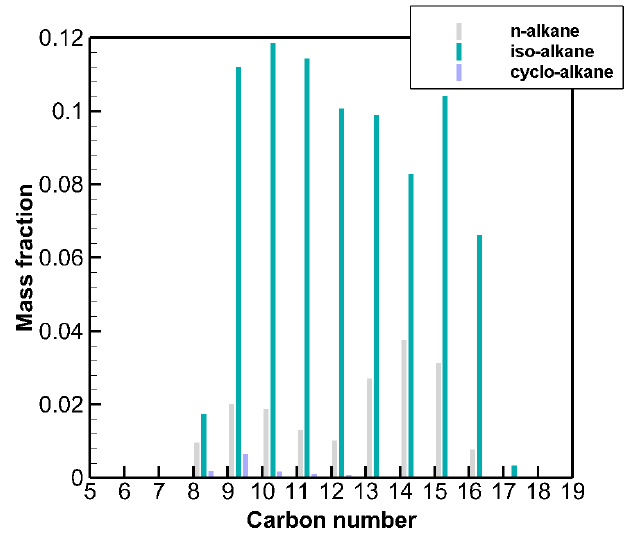
Figure 11. Detailed fuel composition of a HEFA-SPK fuel.